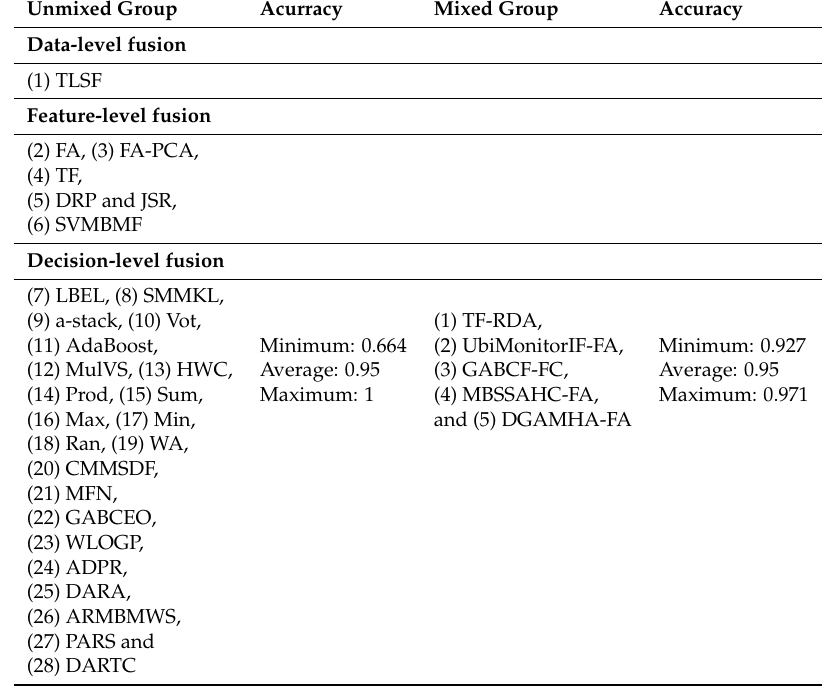
Table 5. The minimum, average and maximum accuracy reached by the “Unmixed” group and by the “Mixed”